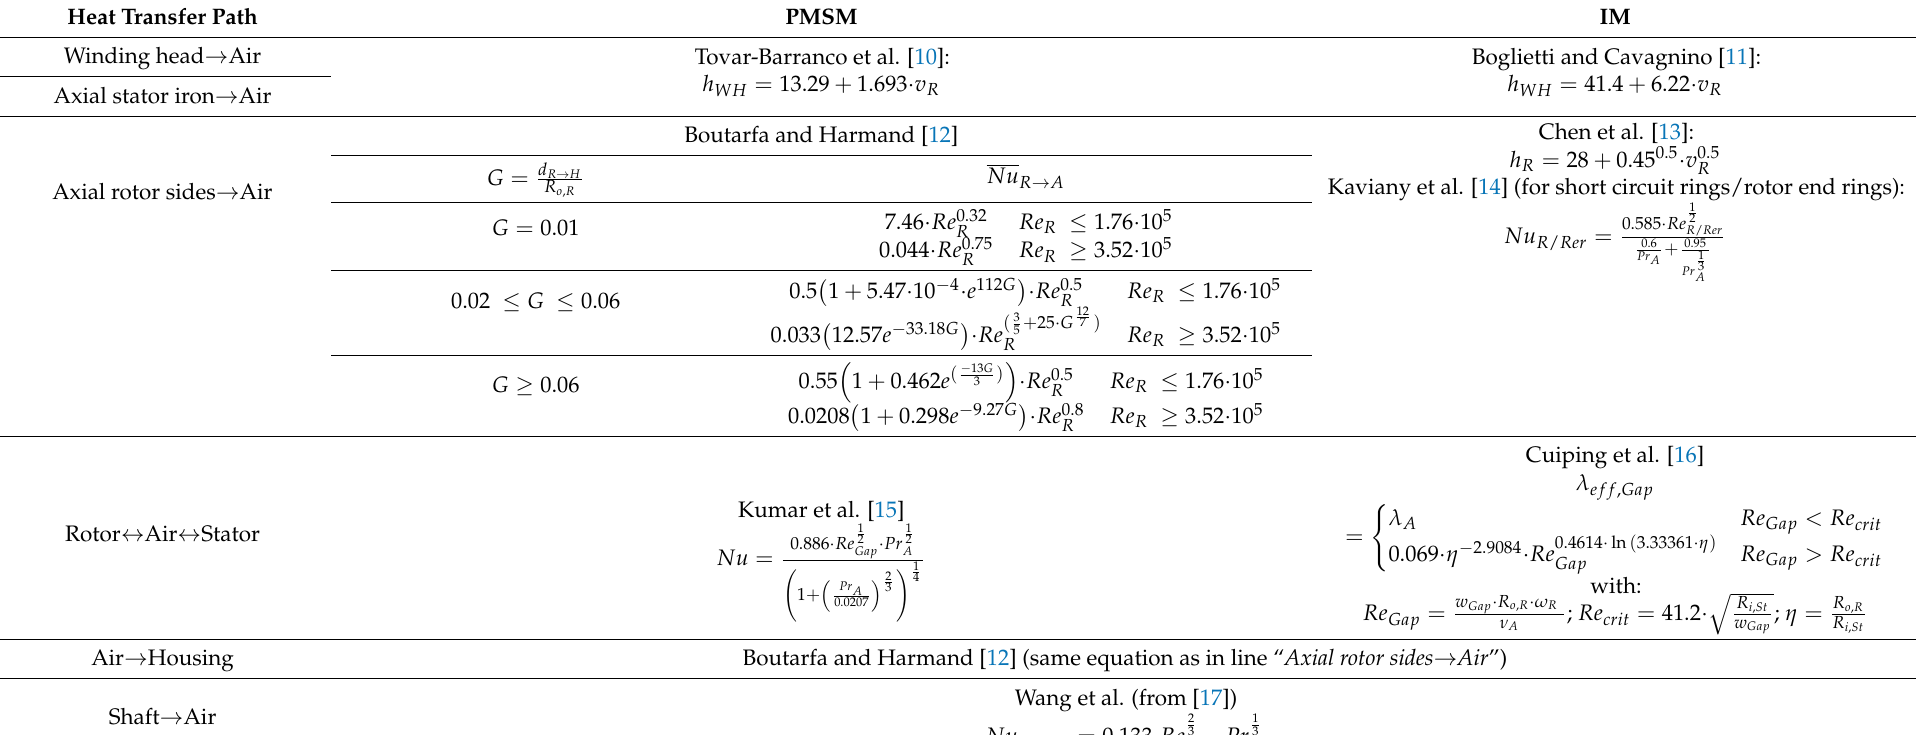
Table 3. Best fitting HTC